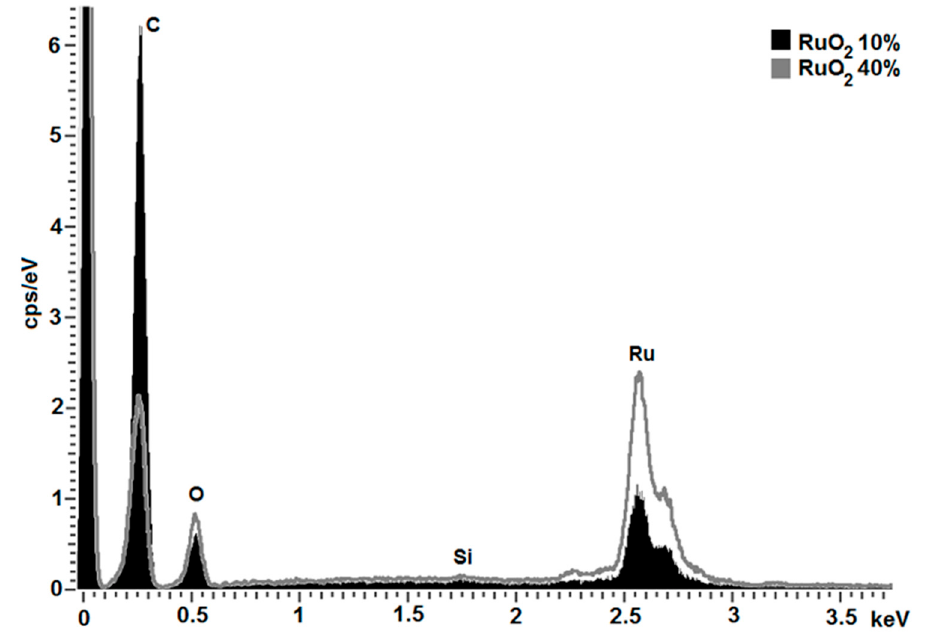
Figure 4. EDX spectrum of samples with RuO 2 with characteristic peaks for Ru, O and C.